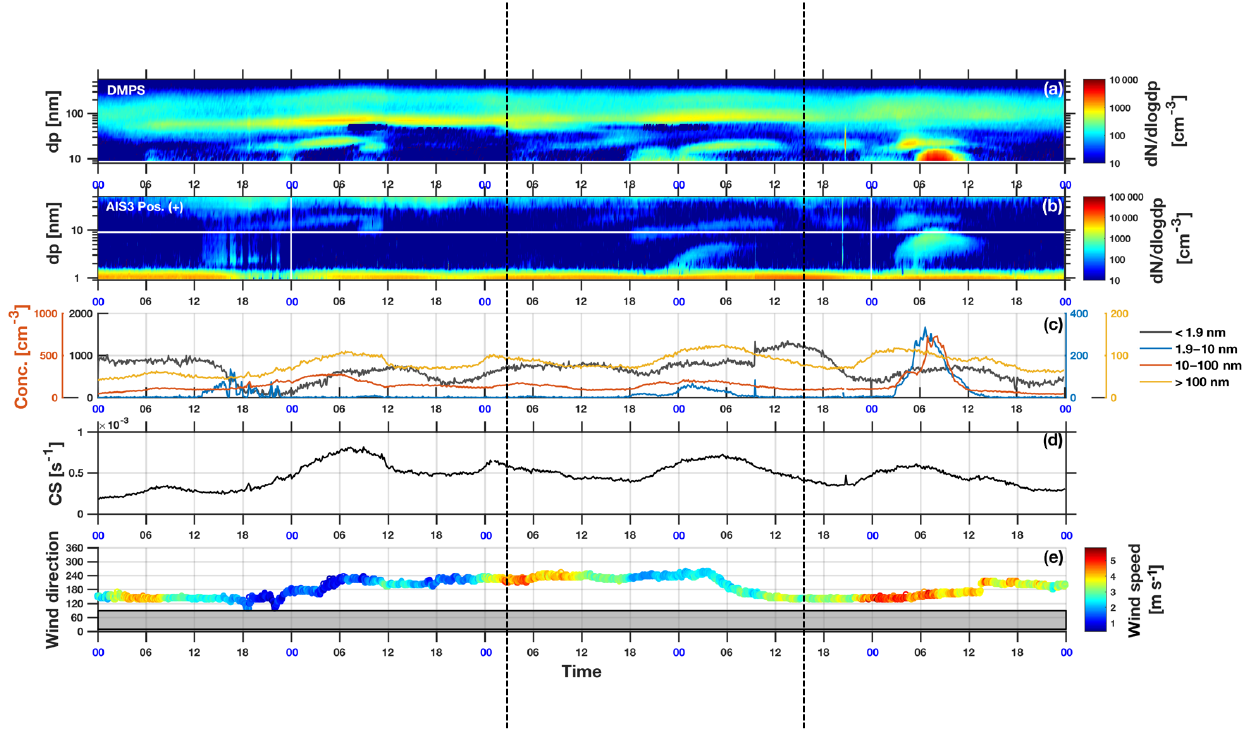
Figure 4. Consecutive multi-mode formation and growth events observed during 12–16 February 2011. (a) DMPS spectra; (b) AIS positive polarity spectra; (c) ion and particle concentrations in four different size ranges 0.9–1.9nm (ions), 1.9–10nm (ions), 10–100nm (total particles), and total particles of diameters above 100nm; (d) CS; and (e) wind direction, colour-coded with wind speed. The white line in (b) indicates the lower limit of the DMPS size range. The grey band in (e) represents the contaminated wind sector. The two vertical dashed lines outline the three NPF which occurred on 14–15 February 2011. Data are presented in UTC.